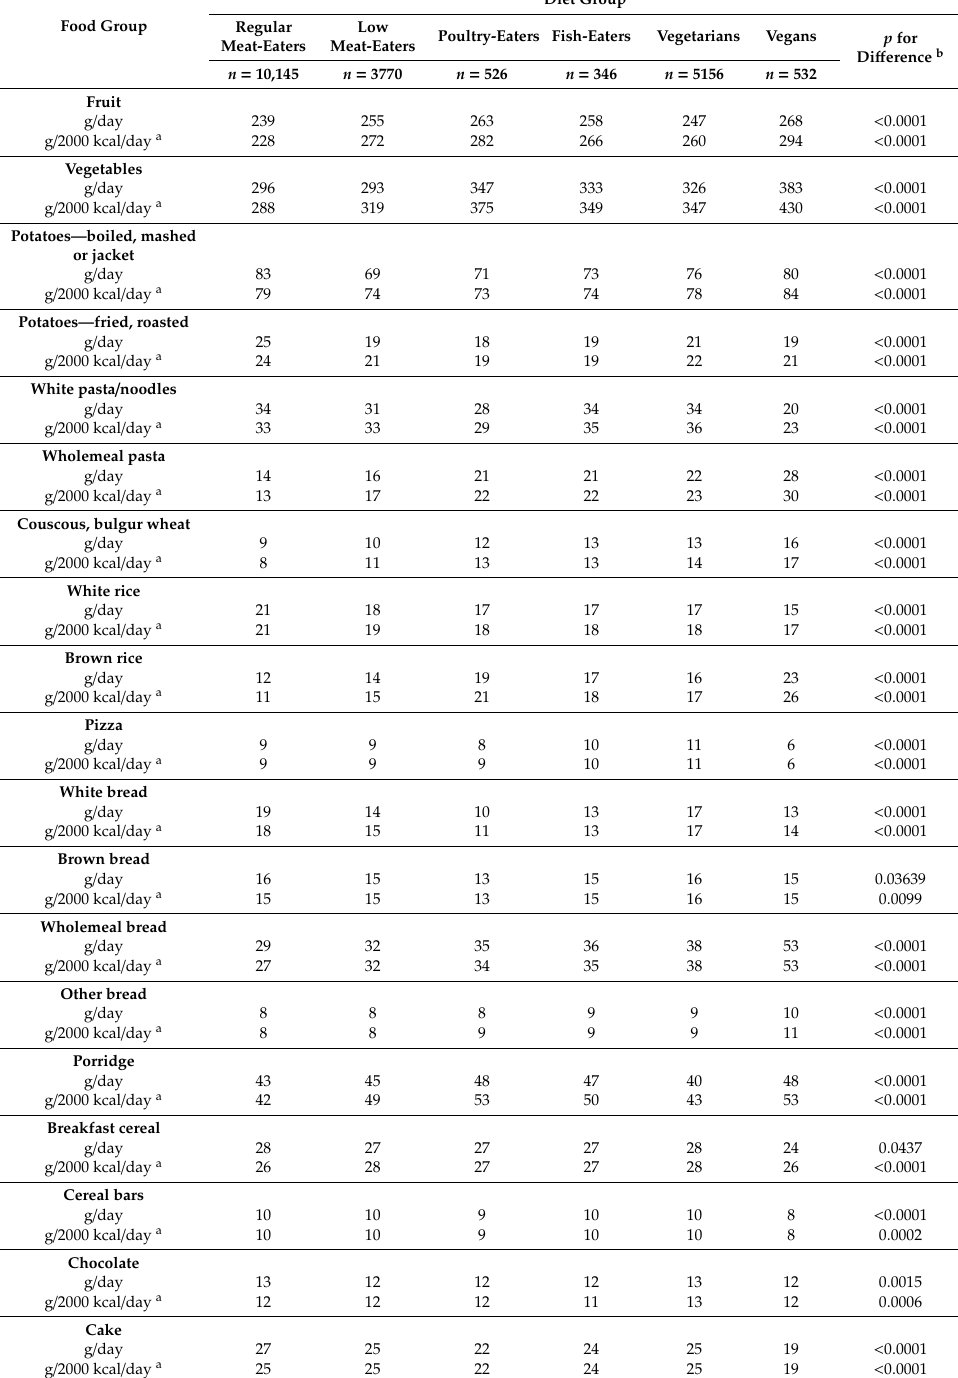
Table 5. Other food group intakes in EPIC-Oxford